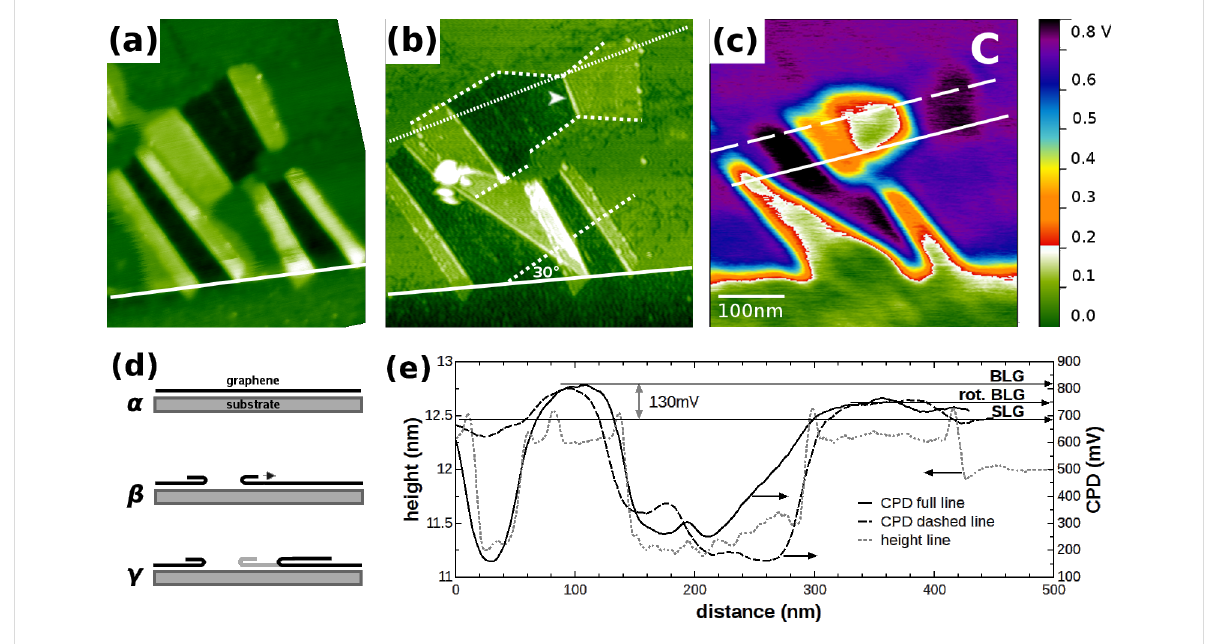
Figure 7: NC-AFM image of the region marked C in Figure 4 with foldings due to SHI impact on the left and right of the ion track prior to (a) and after (b) post-preparation treatment. (b) Large folding created by post-preparation treatment, where the identified edges, zigzag and armchair, are labeled by (white) full and dashed lines and make angles of 30° with respect to each other as exemplified at the bottom. (c) LCPD image taken at the same position but extracted from a different image. (d) Cartoons of the graphene exfoliated on the substrate ( α ), after SHI irradiation creating BLG ( β ), fol- lowed by applying post-preparation methods where the direction of peeling the folding on the right is marked by the arrow ( γ ). (e) Line profiles taken in frames (b) and (c) reveal the same height but a significant difference in the LCPD for the two foldings. The LCPD difference is attributed to the stacking difference as expected from the misalignment of the right folding with respect to the low index crystallographic directions of the SLG